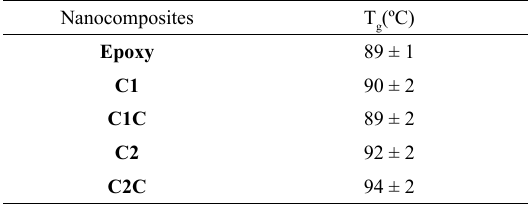
Figure 5. DSC curves for neat epoxy, epoxy/CNT nanocomposites with 0.05 and 0.1 wt % of CNT and epoxy/CNT/calcium carbonate with 0.05 and 0.1 wt % of CNT. ) for neat epoxy, epoxy/CNT Table 1. Glass transitions (T g nanocomposites with 0.05 and 0.1 wt % of CNT and epoxy/CNT/ calcium carbonate with 0.05 and 0.1 wt % of CNT obtained by